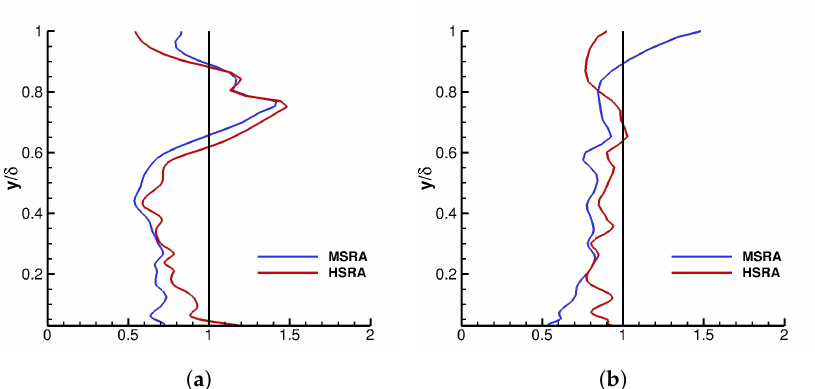
Figure 18. Effect of number of cells in the boundary layer on Strong Reynolds Analogy for condition No. 2: ( a ) 120 cells in the wall normal direction inside the boundary layer. ( b ) 80 cells in the wall normal direction inside the boundary layer.